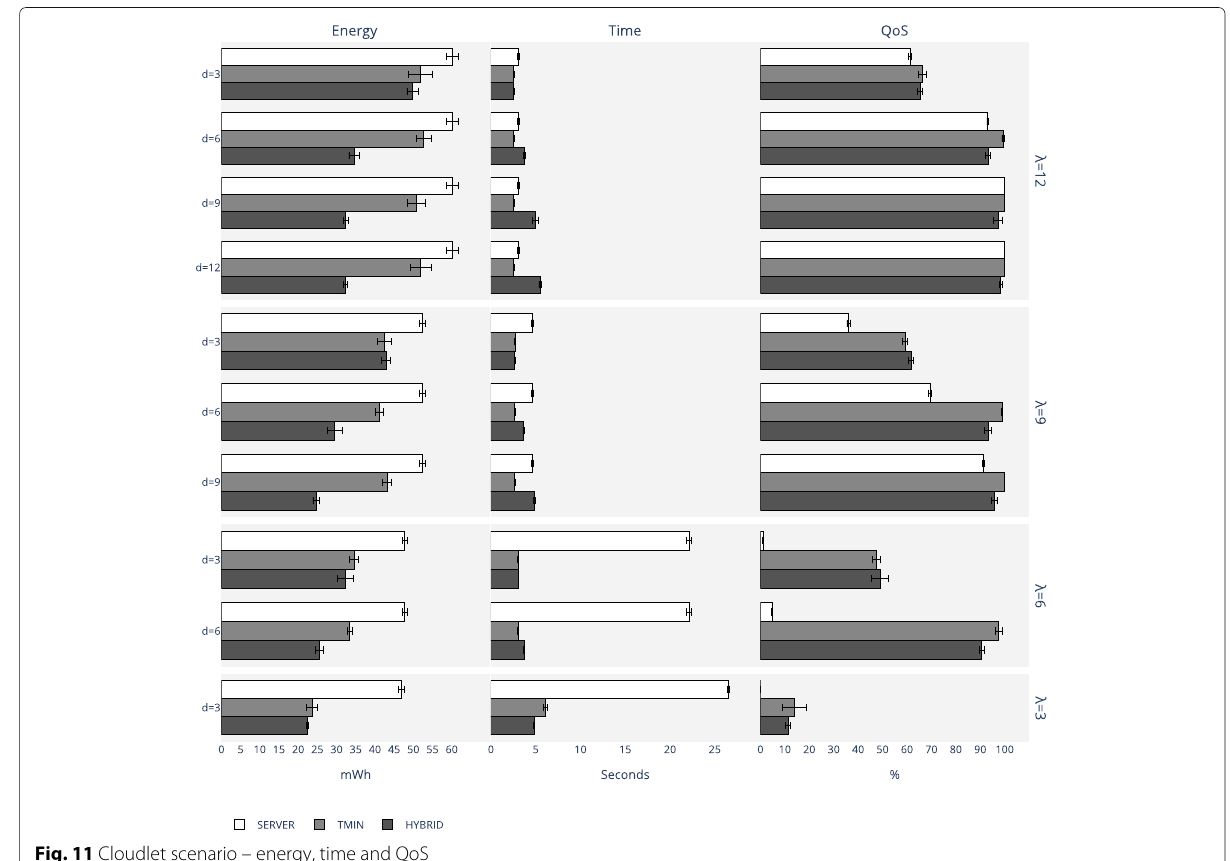
Fig. 11 Cloudlet scenario – energy, time and